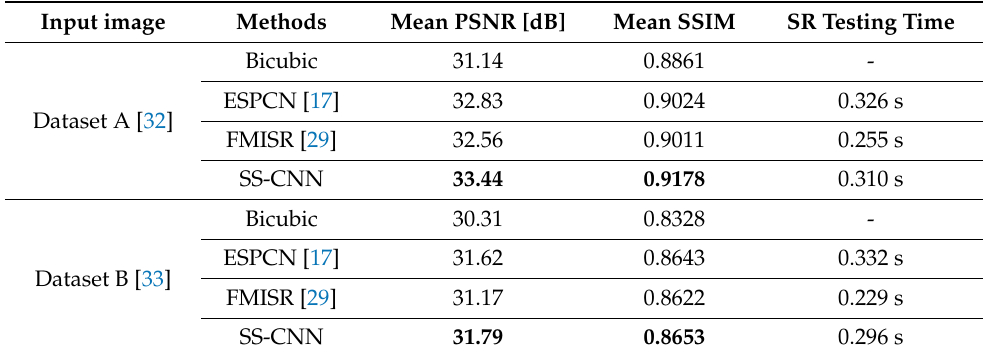
Table 3. Quantitative Analysis of the Proposed SR Model with Current State-of-Art Algorithms. ( 𝑘 = 3) . Bold numbers represent the highest value of SSIM and PSNR.